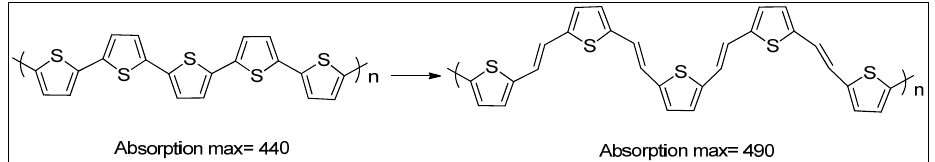
Figure 15. The chemical structure of PT polymers, showing the effect of adding ethylene bonds between the thiophene units in the molecular chain.